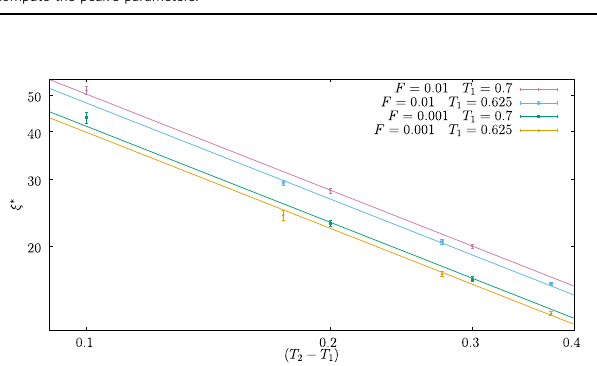
Fig. 5 Universal scaling of dynamic chaos. The characteristic length ξ * is plotted against the temperature difference T 2 − T 1 in a log-log scale. Each curve is uniquely identi fi ed by the probability level F and the smallest temperature of each pair T 1 . Fits to Eq. (6), enforcing a common exponent, are shown with continuous lines and result in a chaotic exponent ζ NE = 1.19(2). Error bars represent one standard